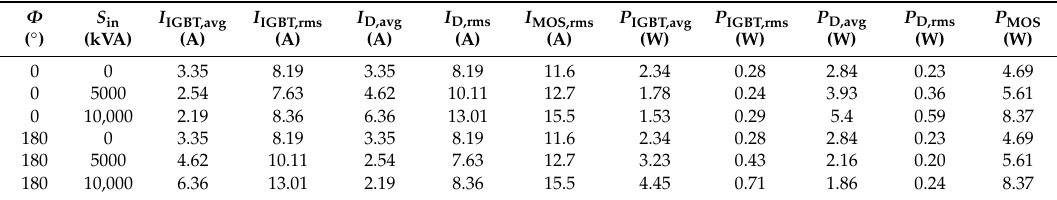
Figure 10. Conduction loss comparison of SiC MOSFET and Si–IGBT with an antiparallel diode for various load situations from 0 to 10 kVA and different phase angles of ( a ) Ф = 0° which results in cos( Ф ) = 1, ( b ) Ф = 45°, ( c ) Ф = 90° and ( d ) Ф = 180°. Table 4. Documented current stress and losses of IGBT with antiparallel diode and SiC–MOSFET for di ff erent phase angles and load